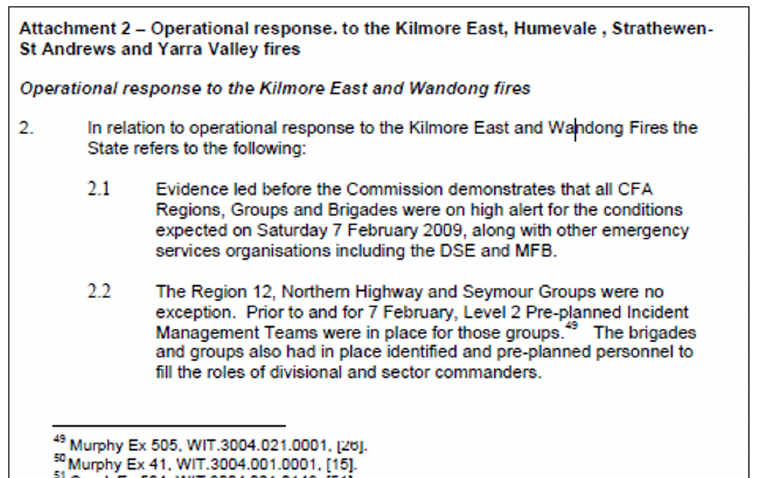
Fig 2. Snapshot of a page of a ‘brief report’ for the “Kilmore East fire” in the 2009 Victorian Bushfires Royal Commission report.